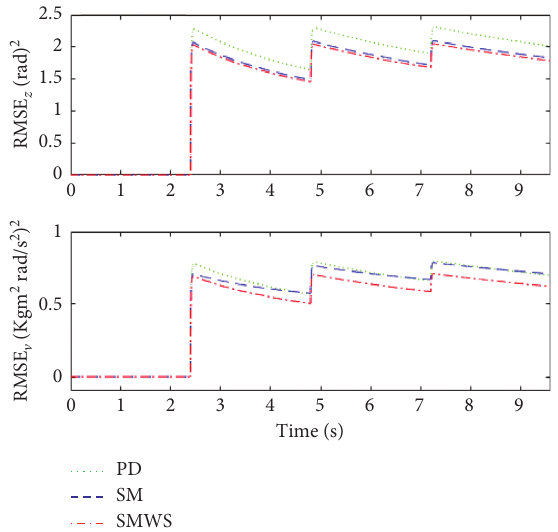
Figure 13: RMSE of the second electricity generator.